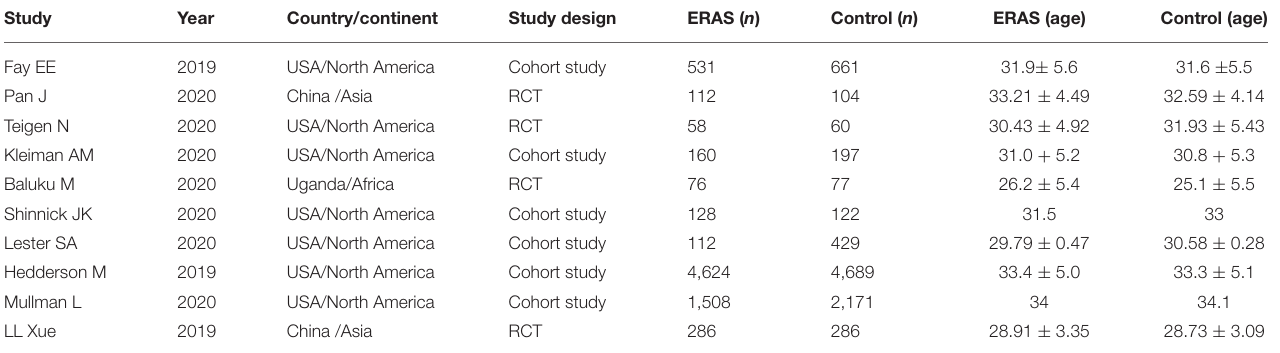
TABLE 1 | Characteristics of included